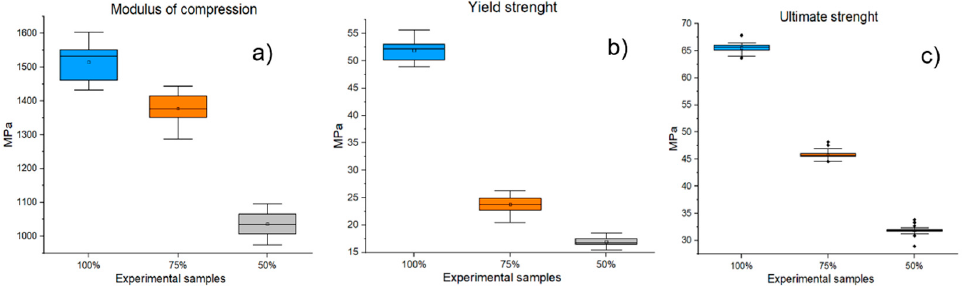
Figure 12. Results of mechanical tensile testing for PLA/PHB + HA/TCP material with infills of 100%, 75%, and 50% infills of experimental samples ( a ) Elastic modulus; ( b ) Modulus of compression; ( c ) Ultimate strength.